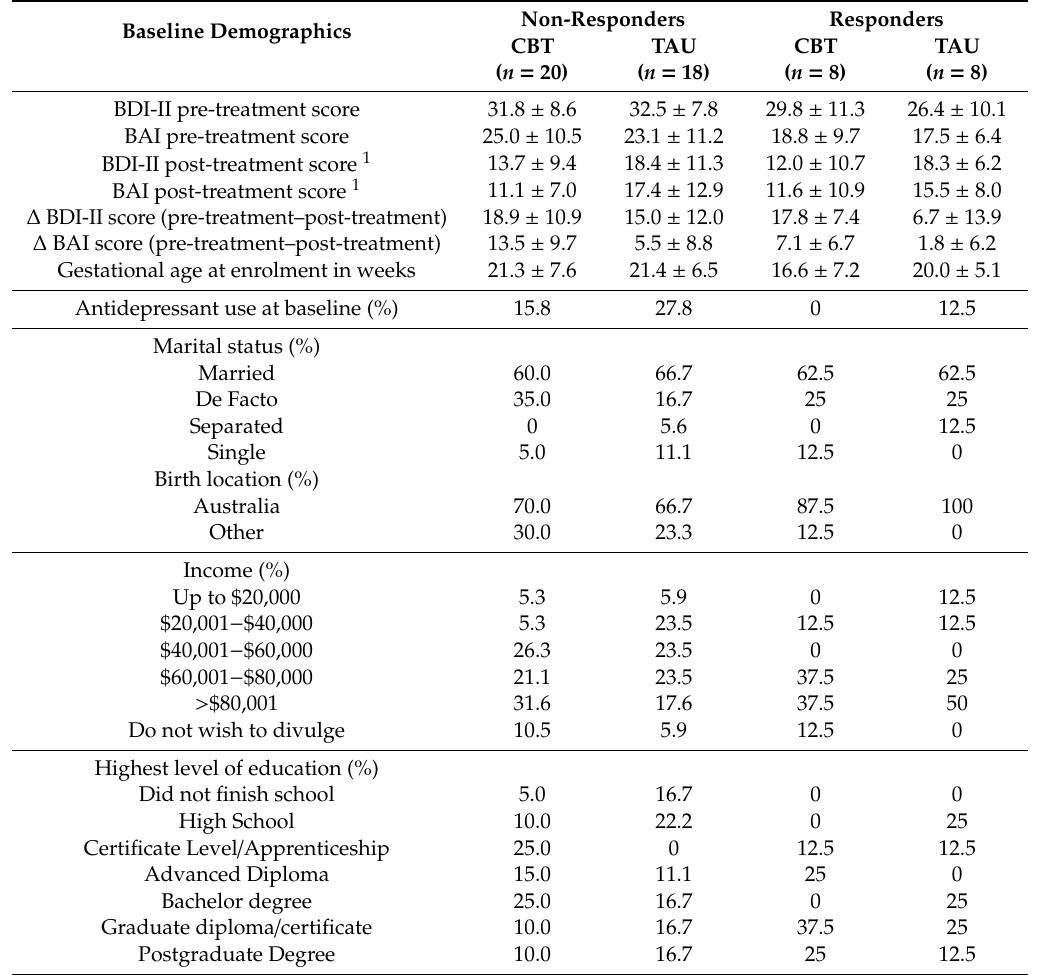
Table 1. Baseline maternal demographics of responders and non-responders of a longitudinal study approximately six years after participation in a pilot Randomized Controlled Trial comparing Cognitive Behavioral Therapy (CBT) and Treatment as Usual (TAU) for antenatal depression.